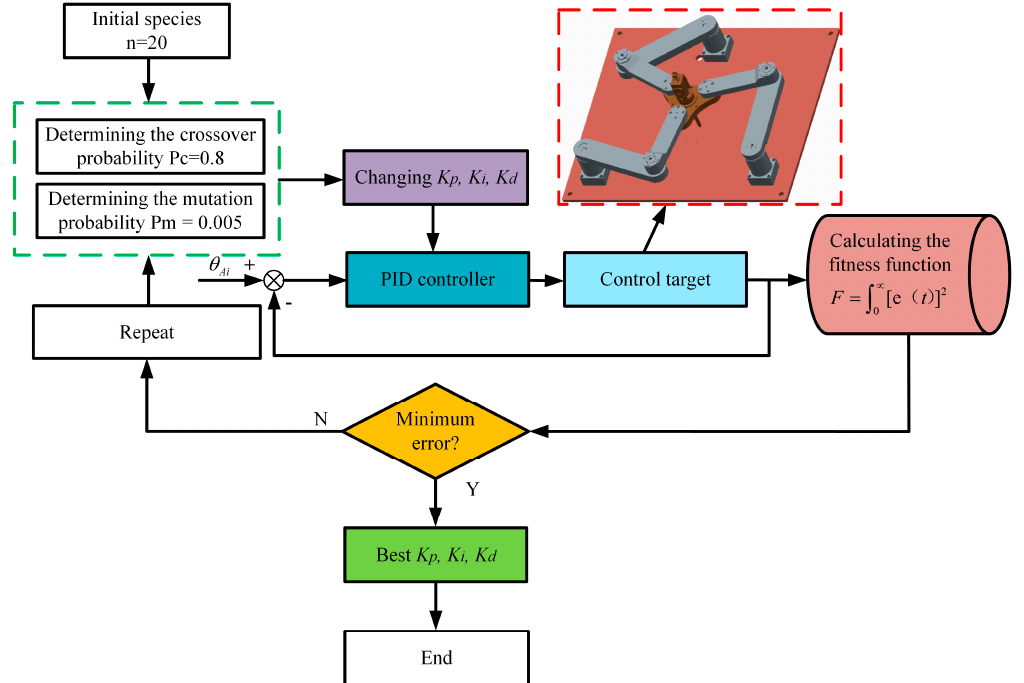
Figure 5. The design flow chart of the genetic algorithm controller.